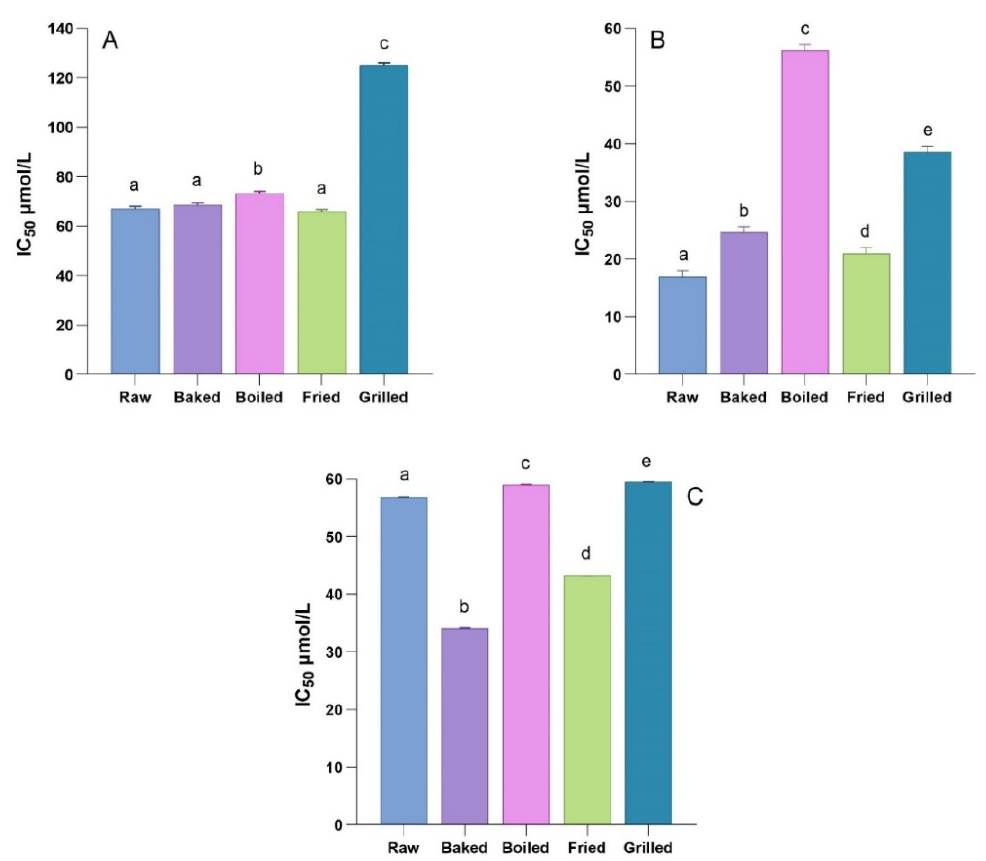
Figure 3. Effect of in vitro digested red-skinned onion phenolic-rich fractions on the activity of key metabolic enzymes. ( A ) Inhibitory activity against α -amylase. ( B ) Inhibitory activity against α -glucosidase. ( C ) Inhibitory activity against dipeptidyl-peptidase IV. The concentration of phenolic compounds (expressed as µ mol of phenolic compounds per mL) required to inhibit the enzymatic activity by 50% (IC50) was calculated by plotting the percentage of the enzyme inhibition with the phenolic compounds concentration (base-10 logarithm). The concentration of phenolic compounds was determined by LC-ESI-IT MS/MS analysis and detailed in Table 2. Different letters mean significant different ( p < 0.05)